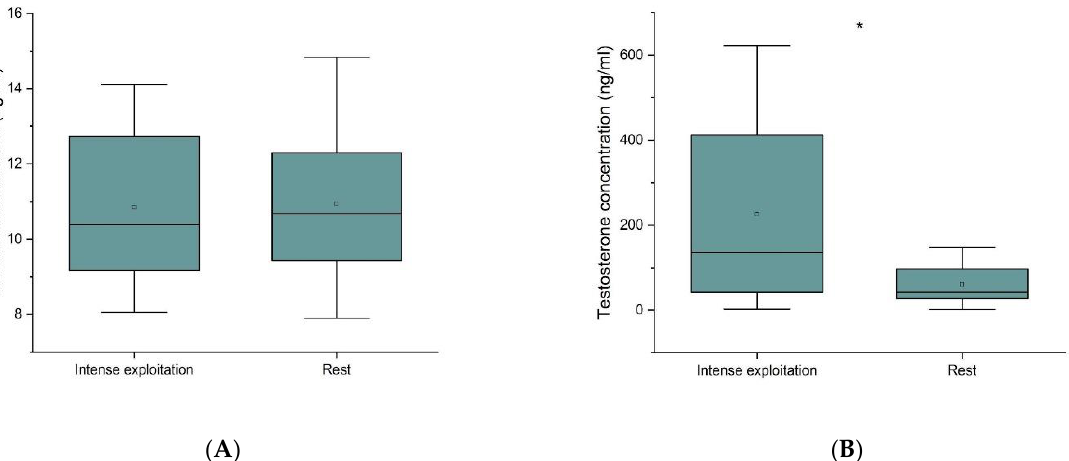
Figure 1. Comparison of serum cortisol ( A ) and testosterone ( B ) concentration measured during the intense leisure exploitation in July and in November, when the horses rested. The box plot presents data distribution (mean, median, and interquartile range) among samples of horses included in the analysis ( n = 8) p < 0.09. * p < 0.09.